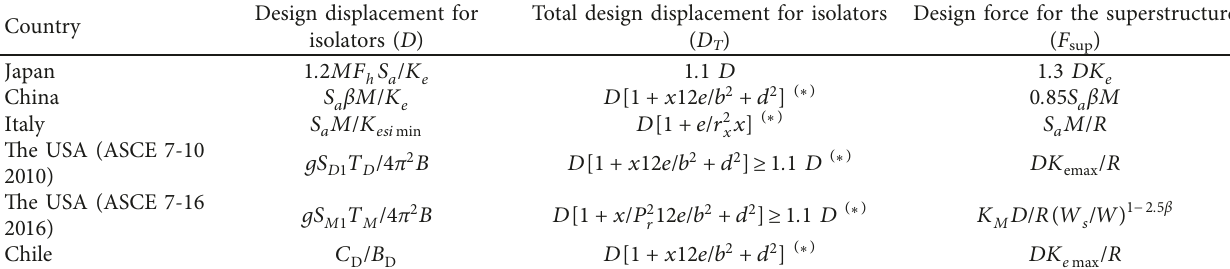
Table 13: The prescriptions of each code for D , D